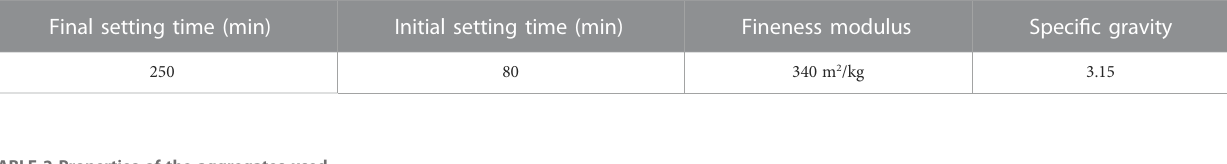
TABLE 2 Properties of the aggregates used.